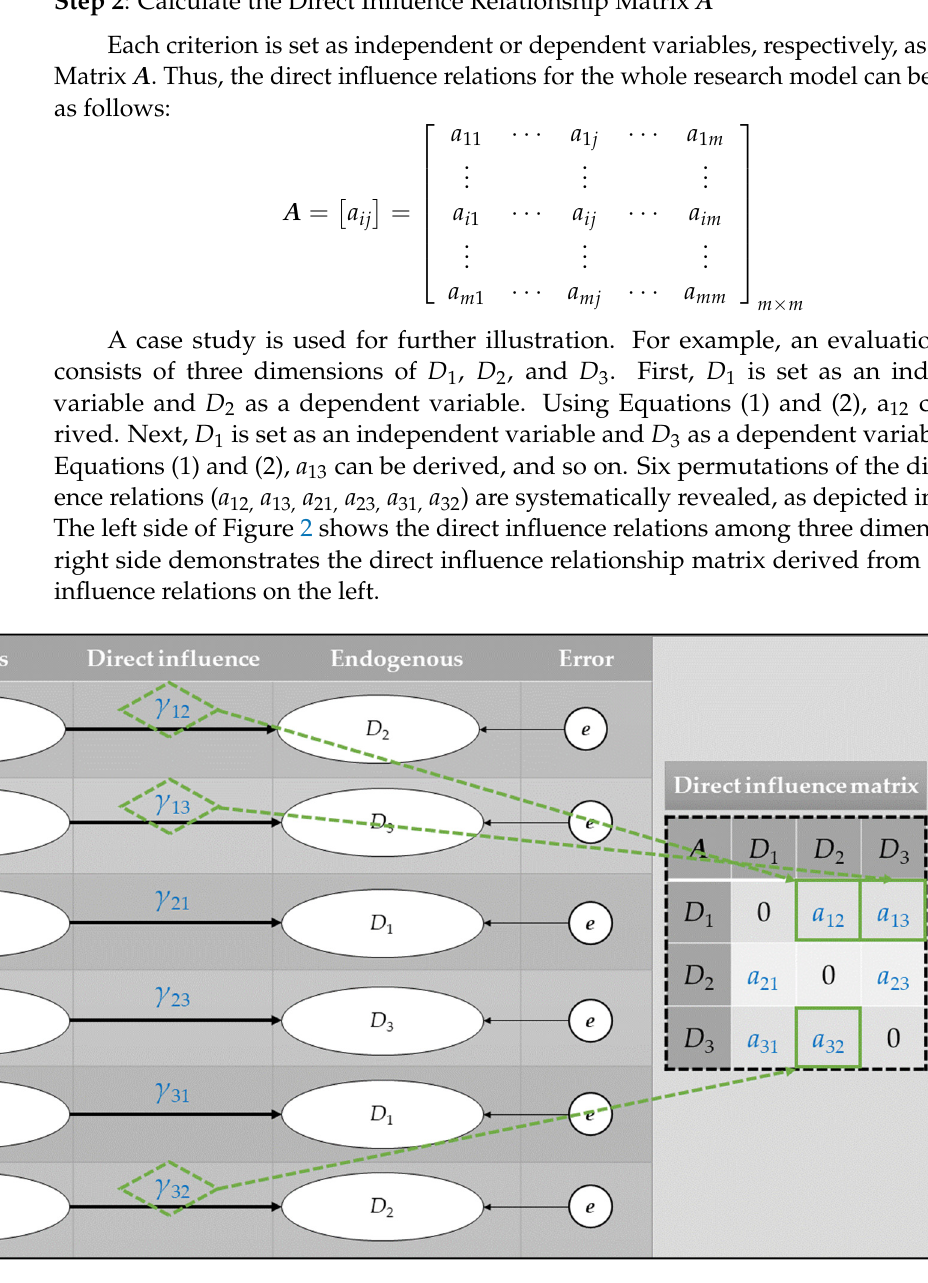
Figure 2. The process of constructing the direct influence Matrix A .